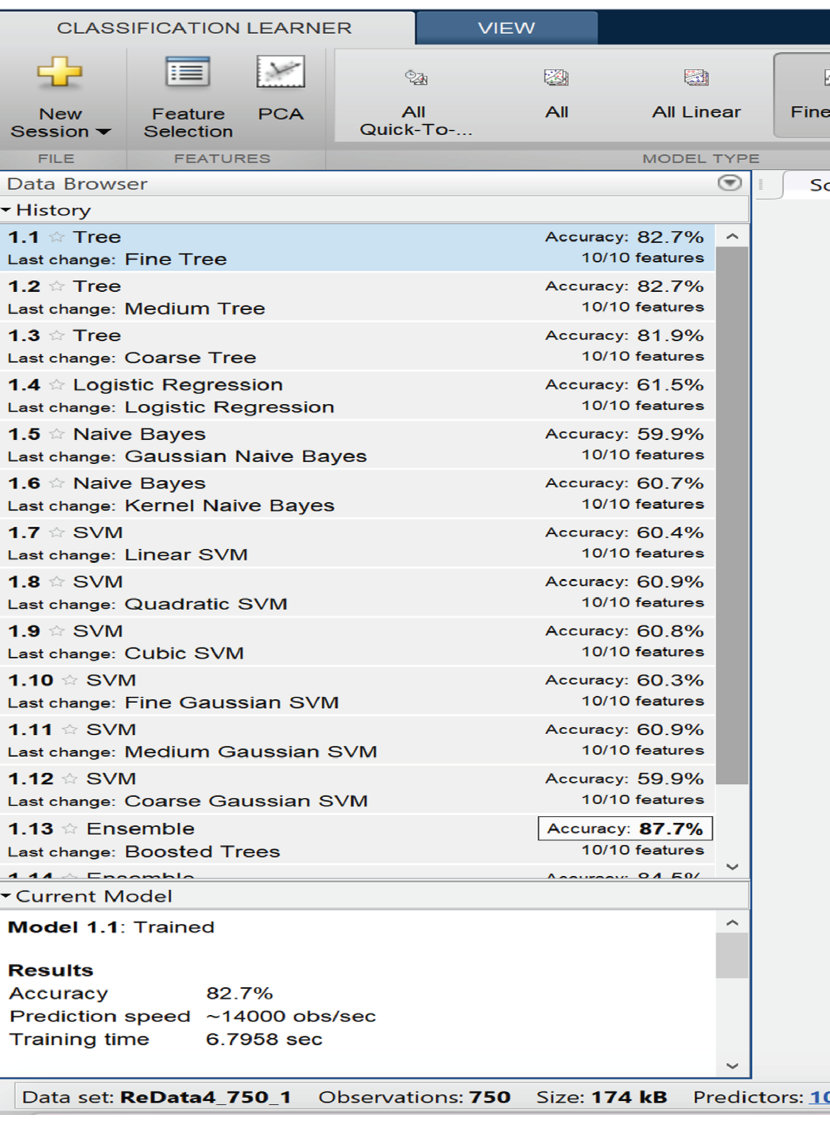
Figure 19: Algorithmic runs on 750-claim